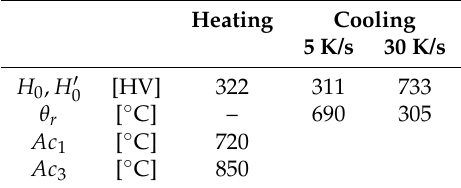
Table 5. Vickers hardness measurements (averaged) and transformation temperatures taken from Figure